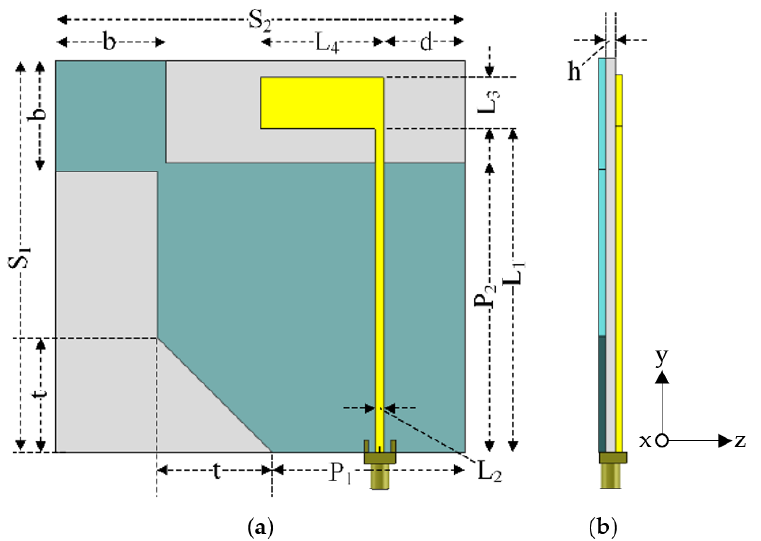
Figure 1. The geometry of the square-branch corner-truncated partial ground plane patch antenna: ( a ) front view, ( b ) side view. Table 1. The optimal dimension of the inverted L-shaped patch antenna with corner-truncated partial ground plane diag- onally adjoined with a square branch (in mm).